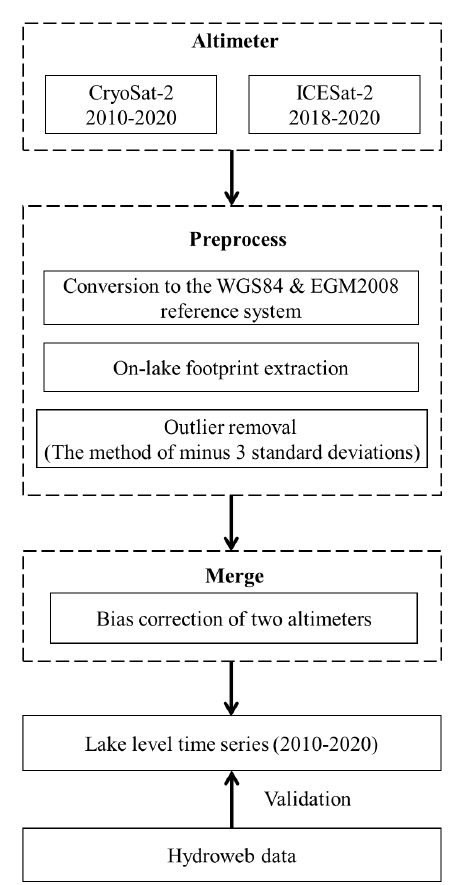
Figure 2 . Flowchart of constructing lake-level time series.